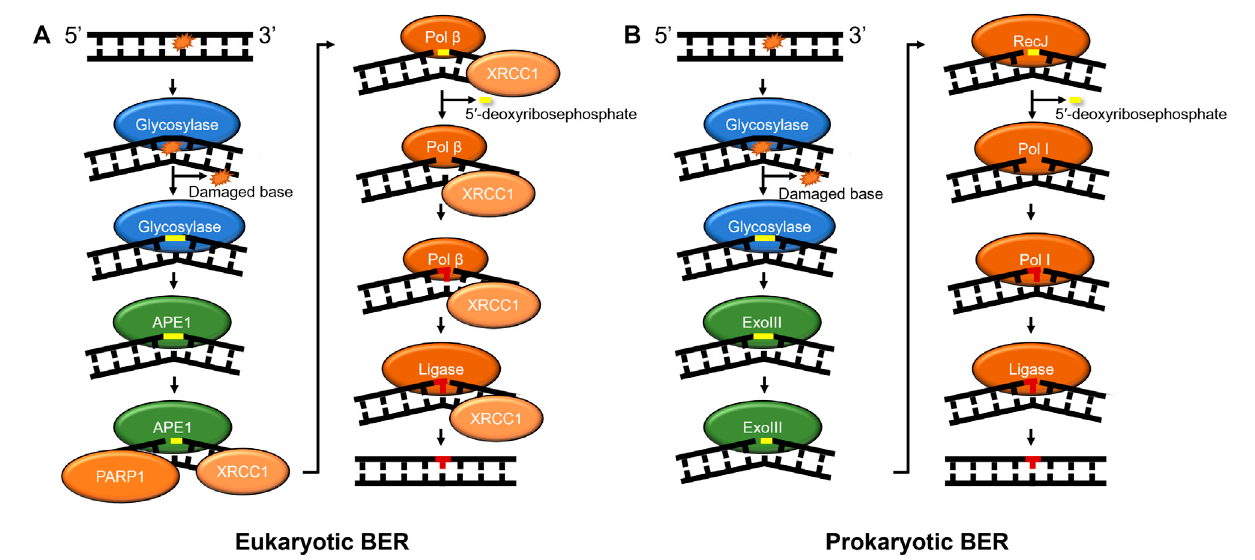
FIGURE 2 | BER pathways in mammals and prokaryotes. (A) Mammalian base excision repair is initiated by a lesion speci fi c glycosylase (monofunctional shown). Subsequently, APE1 further processes the glycosylase product, nicking the phosphate backbone on the 5 ′ side of abasic site. Then, the DNA is processed by the lyase activity of Pol β to remove the 5 ′ -deoxyribosephosphate and the polymerase activity of Pol β regenerates the undamaged sequence which is sealed by DNA ligase. (B) Prokaryotic BER proceeds with similar intermediates to mammalian BER, with some prokaryotes using exonuclease III (XthA) to perform the AP-endonuclease reaction,RecJtoperformthelyasereaction,andPolIinsertingundamagednucleotidestoreplacethedamage.Somebi-functionalglycosylases,suchasNthorEndoIII, with associated lyase activities produce beta-elimination generating a 3 ′ OH and a deoxyribose moiety on the 5 ′ side that needs to be further processed (not shown). Other bi-functional glycosylases like Endo VIII, or NEIL1-3 have associated or beta-delta elimination removing the entire base leaving a one base gap (not shown). As in Figure 1 , proteins are color-coded with damage detection in blue, veri fi cation in gold, incision in green, and repair in red.